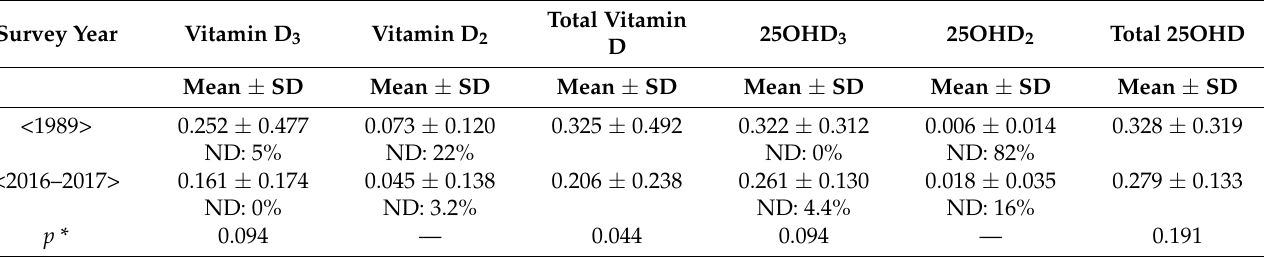
Table 2. Vitamin D and 25OHD concentrations in human breast